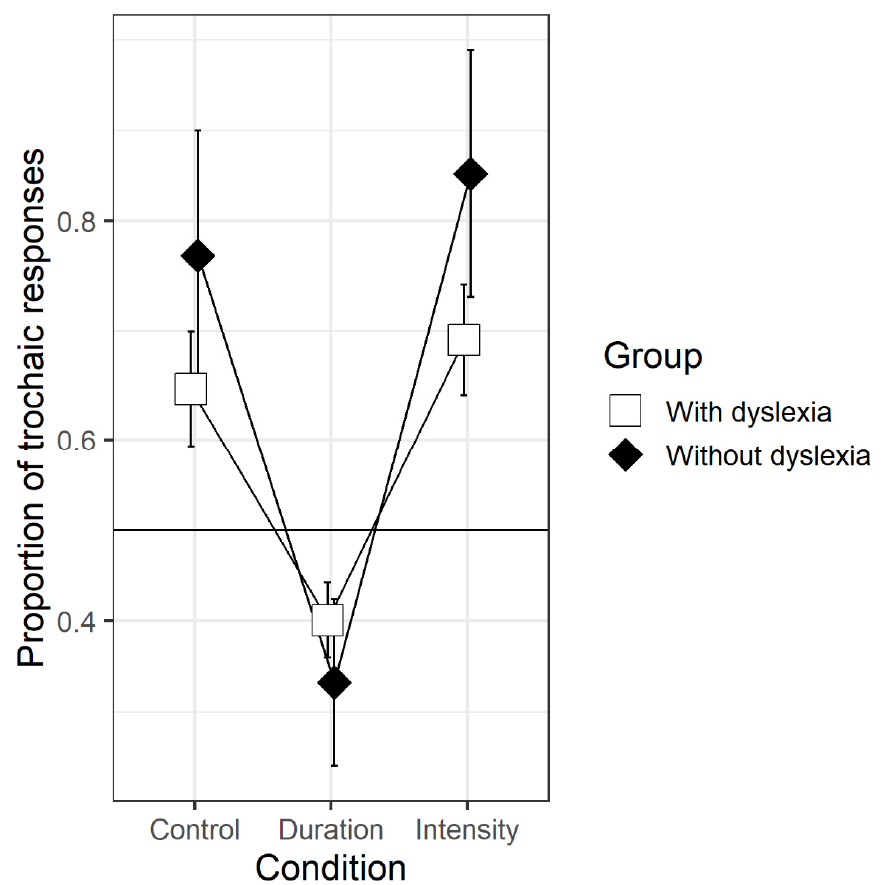
Figure 1. Proportions of trochaic responses (back-transformed, y-axis adjusted to the logit space) in the three acoustic conditions for both groups. The graph reflects the estimates of a simple logit linear mixed-effects model (responses ~ condition * group + (condition + 1||participants) + (1|items)…).